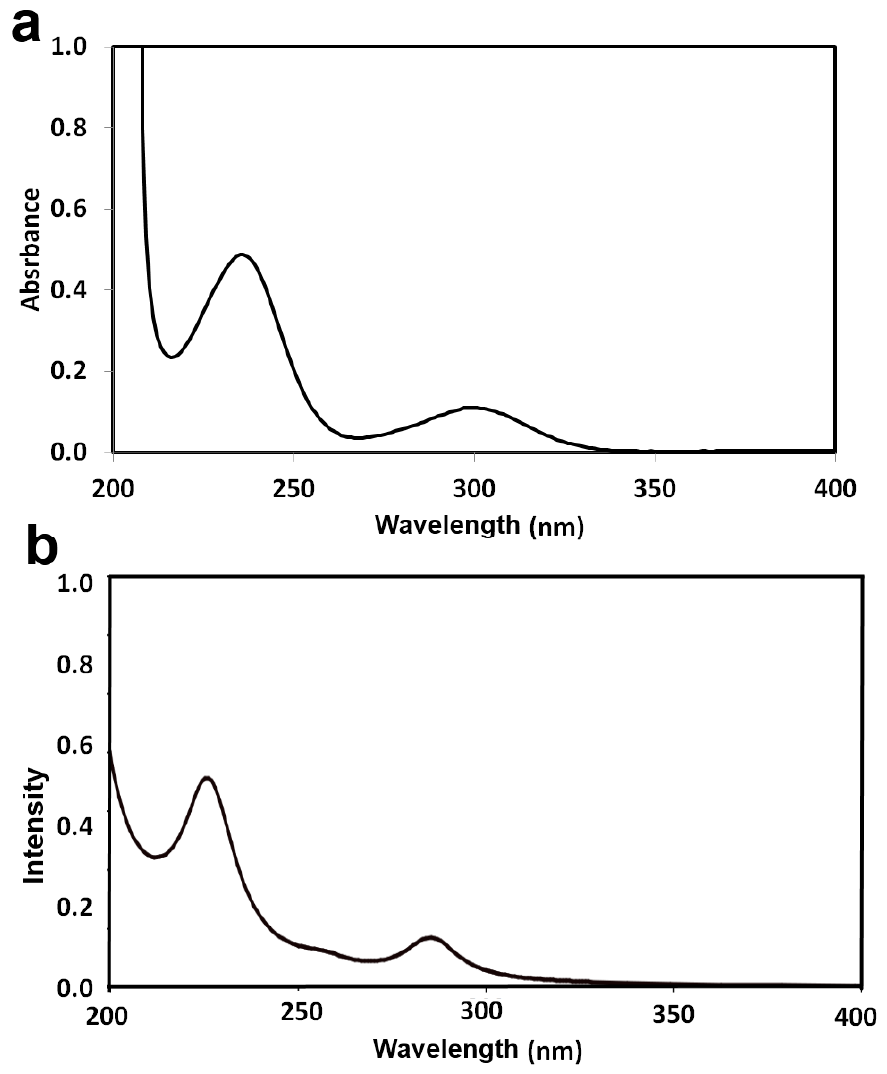
Figure 11. The experimental (a) and calculated (b) UV/Vis spectra of 4 .